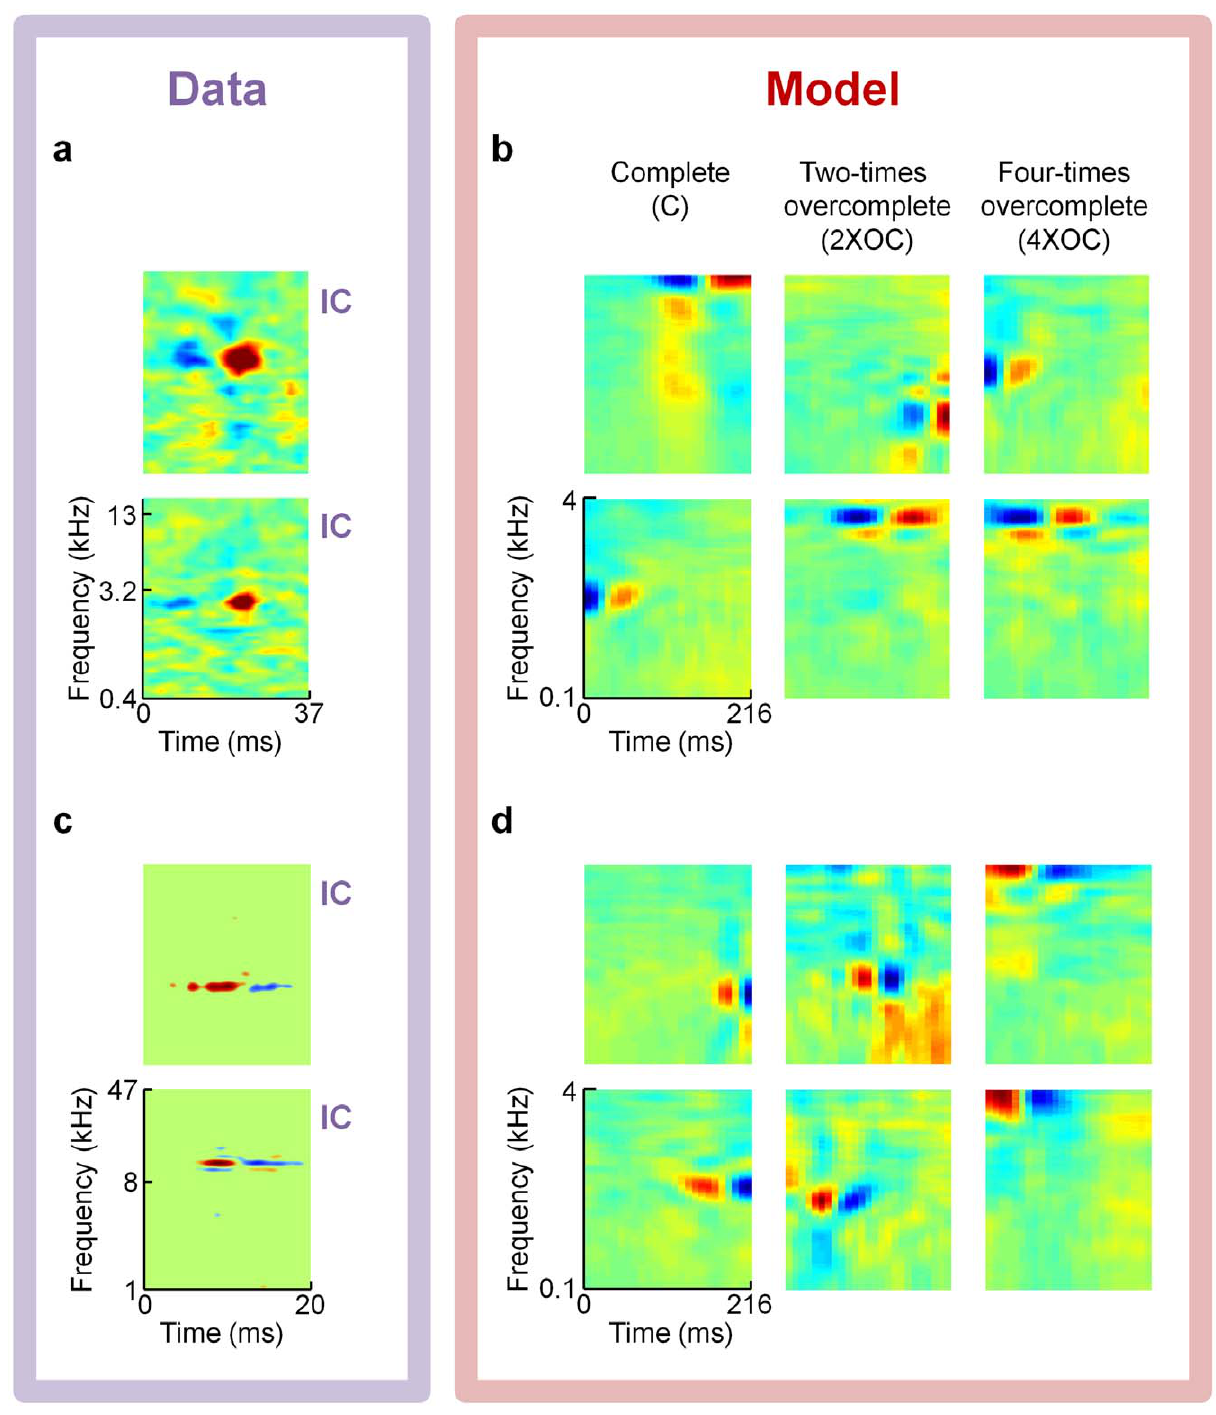
Figure 6. Model comparisons to receptive fields from auditory midbrain. Complete and overcomplete sparse coding models trained on spectrograms of speech predict Inferior Colliculus (IC) spectro-temporal receptive field (STRF) shapes with excitatory and suppressive subfields that are localized in frequency but separated in time. ( a ) Two examples of Gerbil IC neural STRFs [31] exhibiting ON-type response patterns with excitation following suppression; data courtesy of N.A. Lesica. ( b ) Representative model dictionary elements from each of three dictionaries that match this pattern of excitation and suppression. The three dictionaries were all trained on spectrogram representations of speech, using a hard sparseness (L0) penalty; the representations were complete (left column; Fig. S2 ), two-times overcomplete (middle column; Fig. S3 ), and four-times overcomplete (right column; Fig. 4 and Fig. S4 ). ( c ) Two example neuronal STRFs from cat IC [30] exhibiting OFF-type patterns with excitation preceding suppression; data courtesy of M.A. Escabı´. ( d ) Other model neurons from the same set of three dictionaries as in panel b also exhibit this OFF-type pattern.